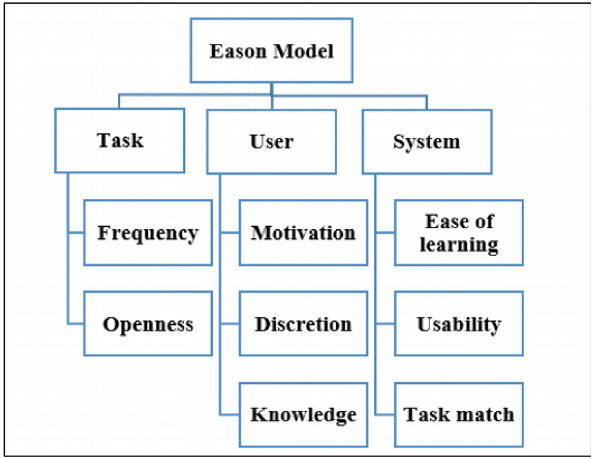
Figure 1. The sub-attribute for each dimension in Eason’s model